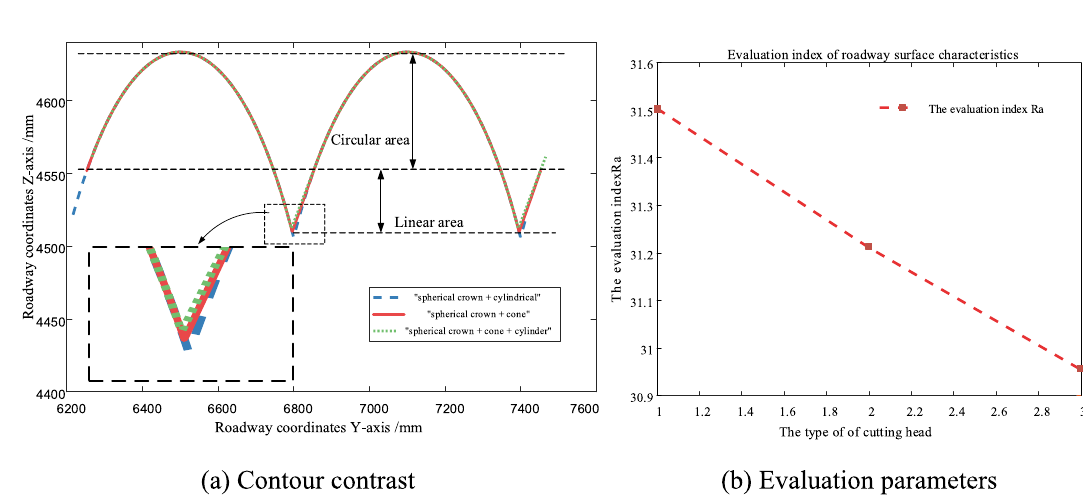
Figure 6. Comparison of roadway section under different cutting head